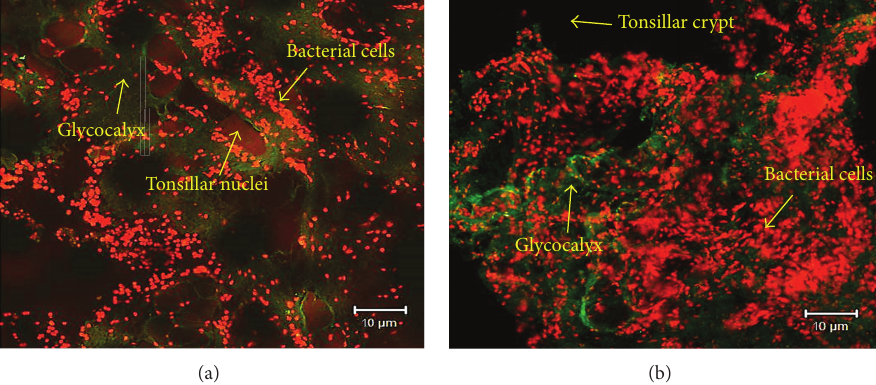
Figure 4: Microscopic evidence of bacterial biofilms within the tonsillar crypts via CLSM. (a) Representative image of biofilm from a patient with obstructive sleep apnea showing bacterial cells (red) embedded with glycocalyx (green) surrounding the tonsillar nuclei (red). (b) Three- dimensional image of a biofilm showing bacterial aggregates (cells) embedded in a glycocalyx matrix (100x). Arrows indicate the biofilm structures and tissue sections were stained with propidium iodide and concanavalin